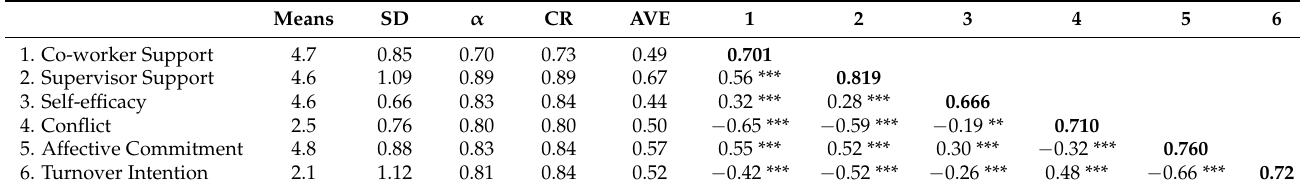
Table 1. Means, standard deviations, internal consistencies and